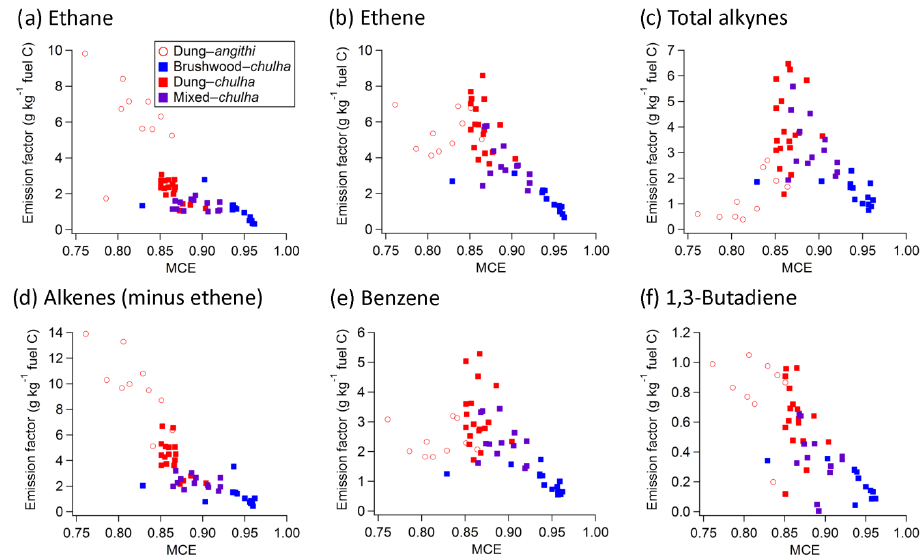
Figure 3. Emission factors as a function of modified combustion efficiency (MCE) for select species. Open circles indicate cooking events conducted with angithi stoves, whereas filled squares indicate chulha stoves. Color indicates fuel: brushwood (blue), dung (red), or mixed (purple). 1-Buten-3-yne is grouped in with